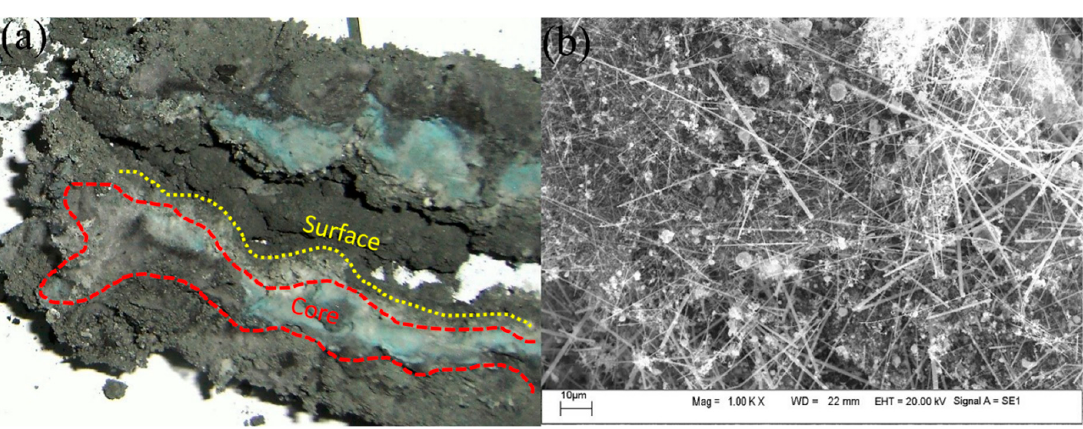
Figure 2. CSed SiC NWs without W as the catalyst: ( a ) sample morphology and ( b ) typical scanning electron microscope (SEM) images revealing the existence of residual particles in the NWs.